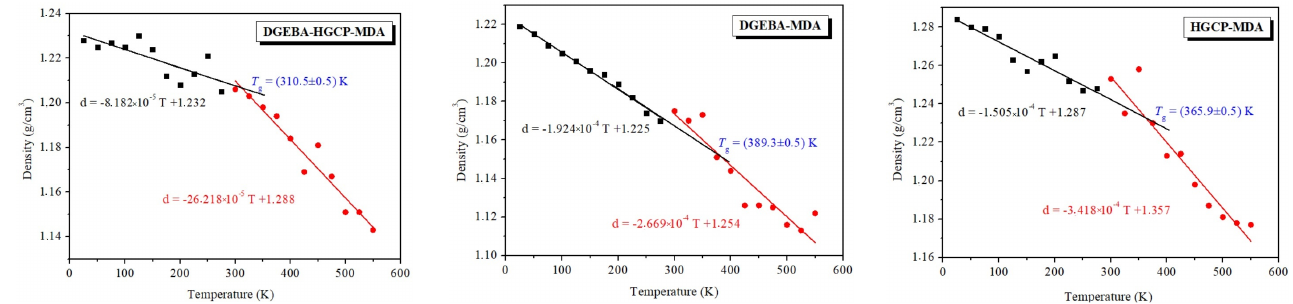
Figure 7. Temperature-dependent mass density of DGEBA@HGCP@MDA, HGCP@MDA, and DGEBA@MDA materials. The outcomes of MD simulations.